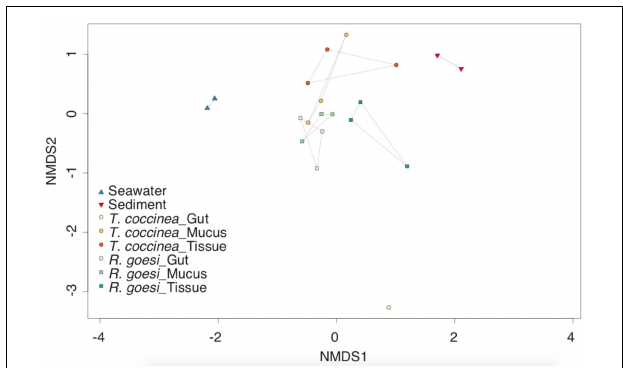
FIGURE 1 | Two-dimensional non-metric multidimensional scaling (nMDS) ordination depicting variation in microbial community structure among the cup corals Rhizopsammia goesi and Tubastrea coccinea across polyp compartment: surface mucus layer, tissue, and gastrovascular cavity (or “gut”). Seawater and sediment samples added as reference to all plots. Polygons delimitate the distribution of each sampling group within the nMDS.